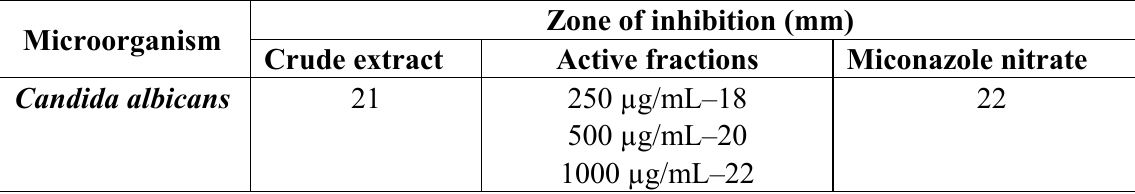
Table 2. Zone of inhibition of Cassia fistula seeds extract, active fraction and commercial antibiotics against Candida